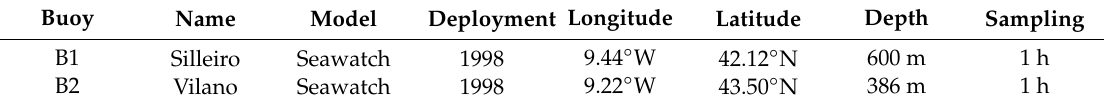
Table 1. Description of the buoys deployed within HFR